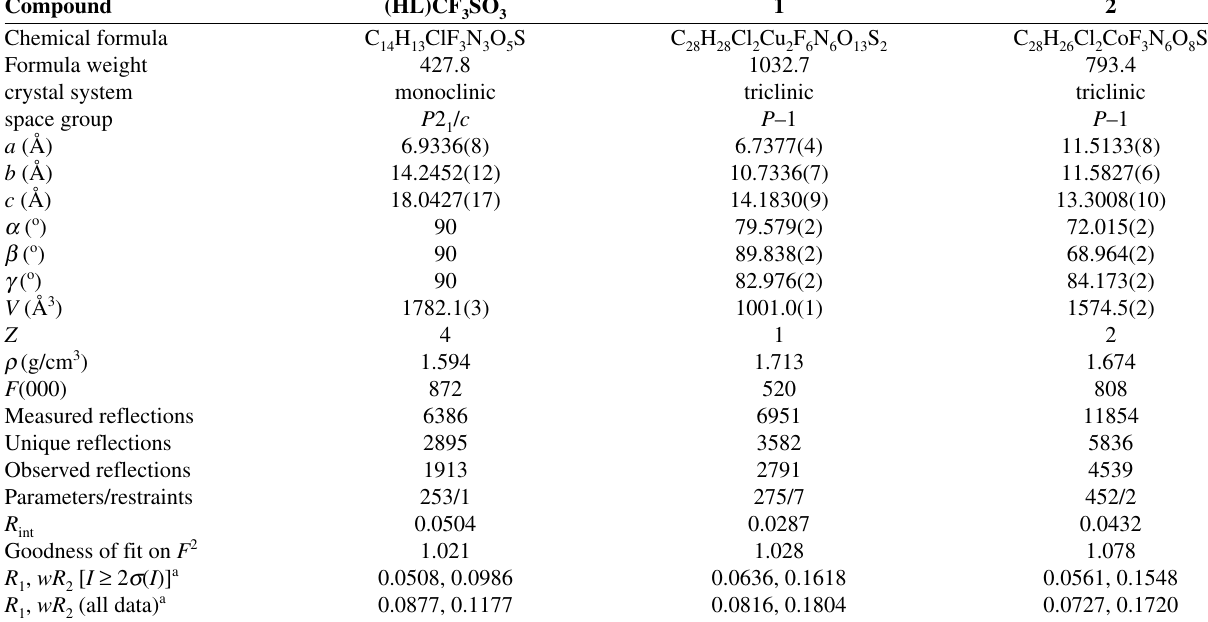
Table 1. Crystallographic and experimental data for the compounds Compound (HL)CF